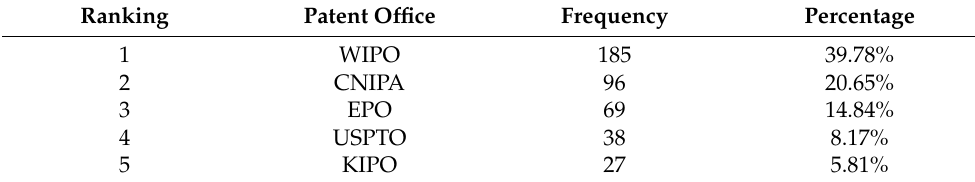
Table 1. Patent offices that granted SEPs.